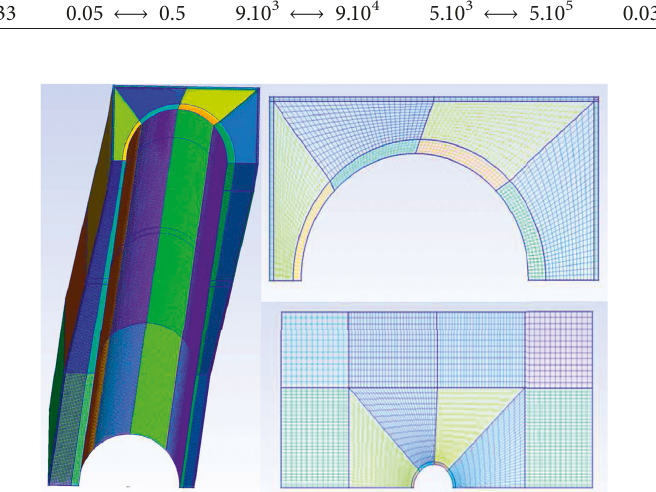
Figure 5: Example of meshes used for the simulations.